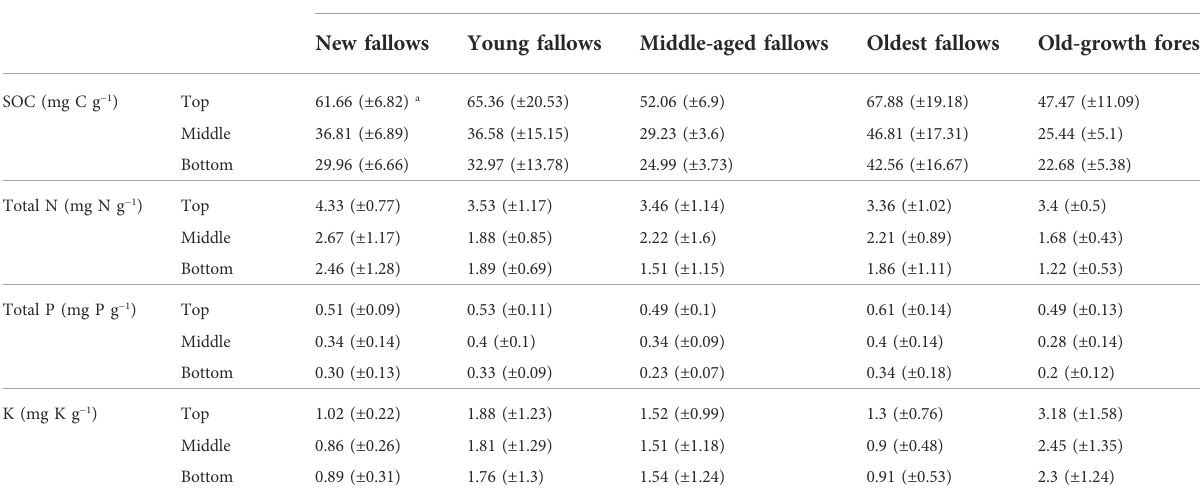
a Values in the parentheses indicate the standard deviations of means under respective